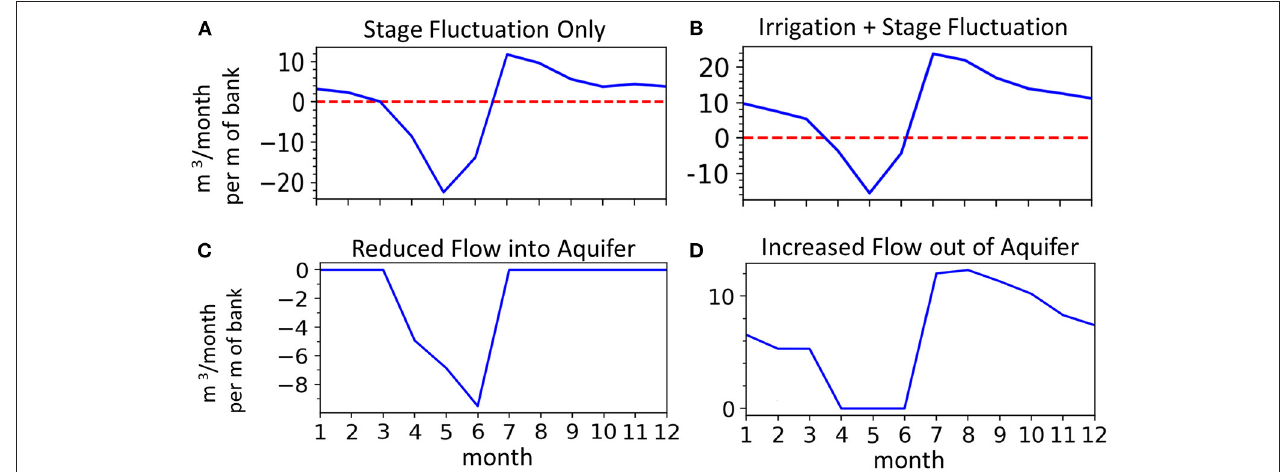
FIGURE 4 | Example model results showing SW-GW flux across the stream-aquifer boundary for the baseline case of stage fluctuation (A) and with both irrigation recharge and stage fluctuation (B) . Compared to the baseline case, irrigation recharge reduces stream-aquifer exchange during April-June (C) and increases groundwater discharge (return flows) during the rest of the year (D) .